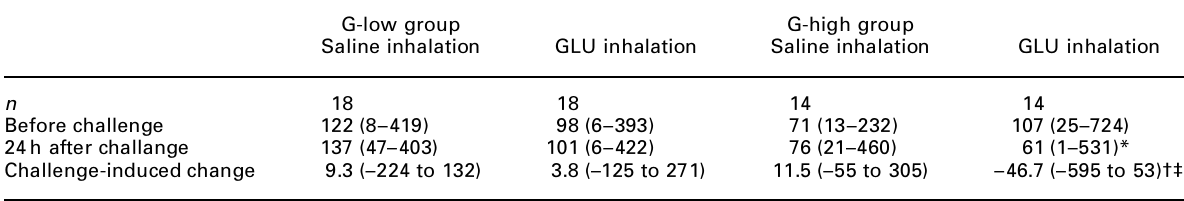
Table 2. TNF a (pg/ml) secreted from PBMC stimulated with LPS in vitro before and 24h after saline and (1 ® 3)- b - D -glucan (GLU) inhalations G-low group G-high group Saline inhalation GLU inhalation Saline